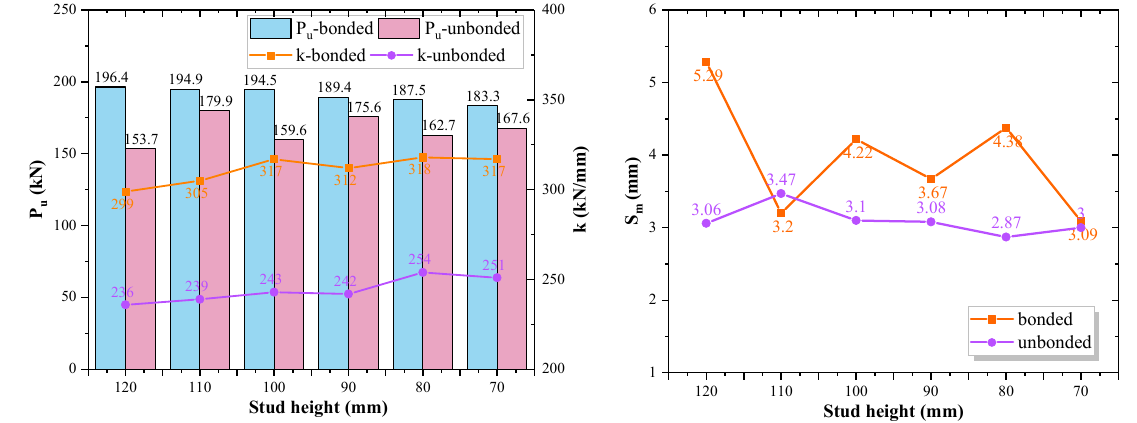
Figure 21. Influence of stud height on ultimate strength, shear stiffness and slip.